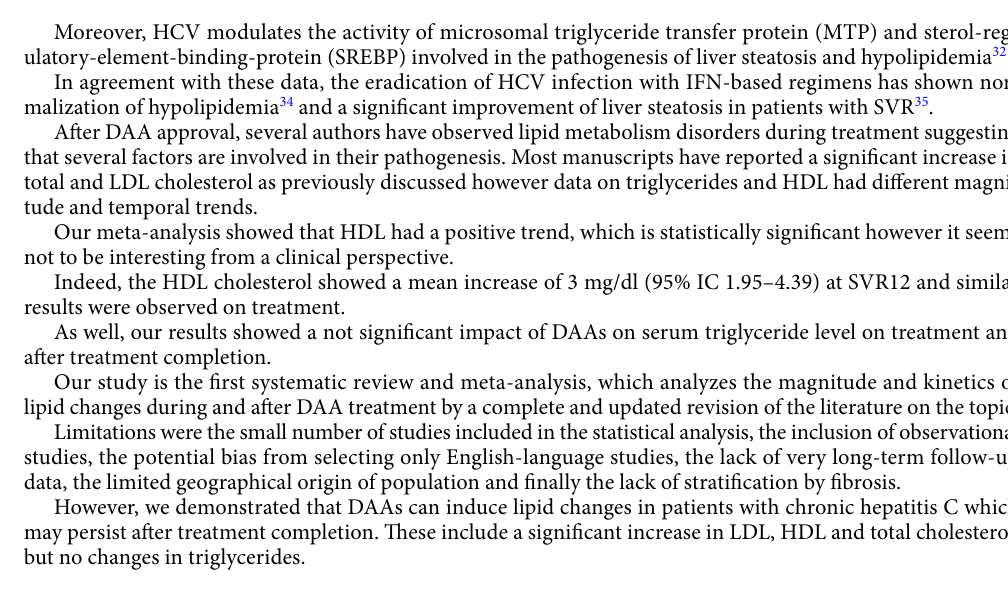
paritaprevir/ritonavir/ombitasvir + dasabuvir, SOF/SMV sofosbuvir +